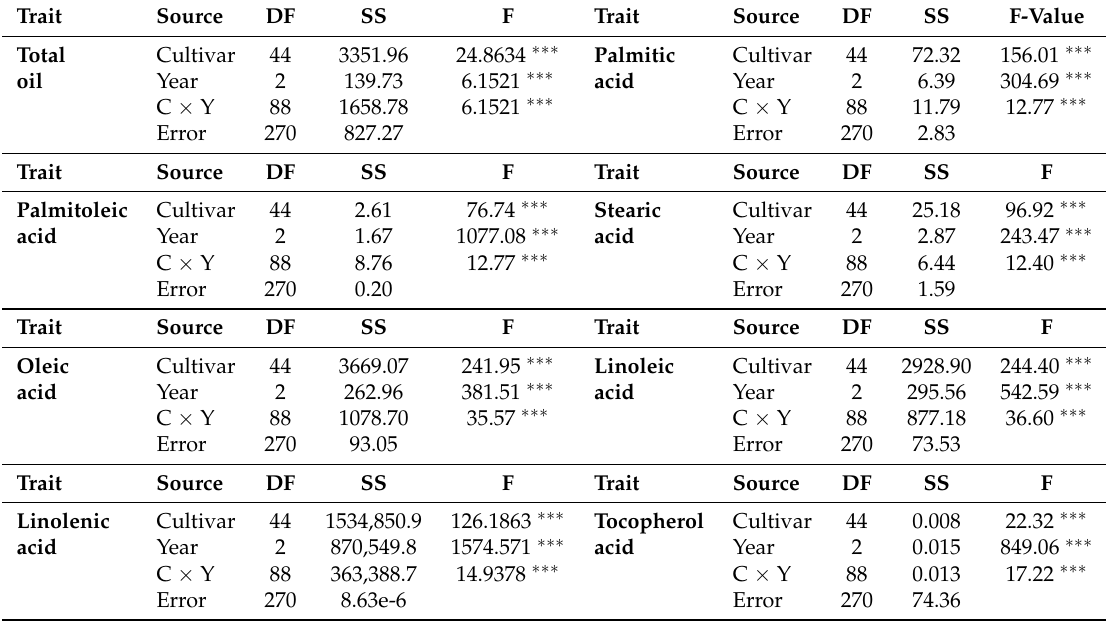
Table 4. Analysis of variance for commercial traits of the almond cultivars. *** corresponds to p < 0.001. C × Y means the interaction Cultivar by